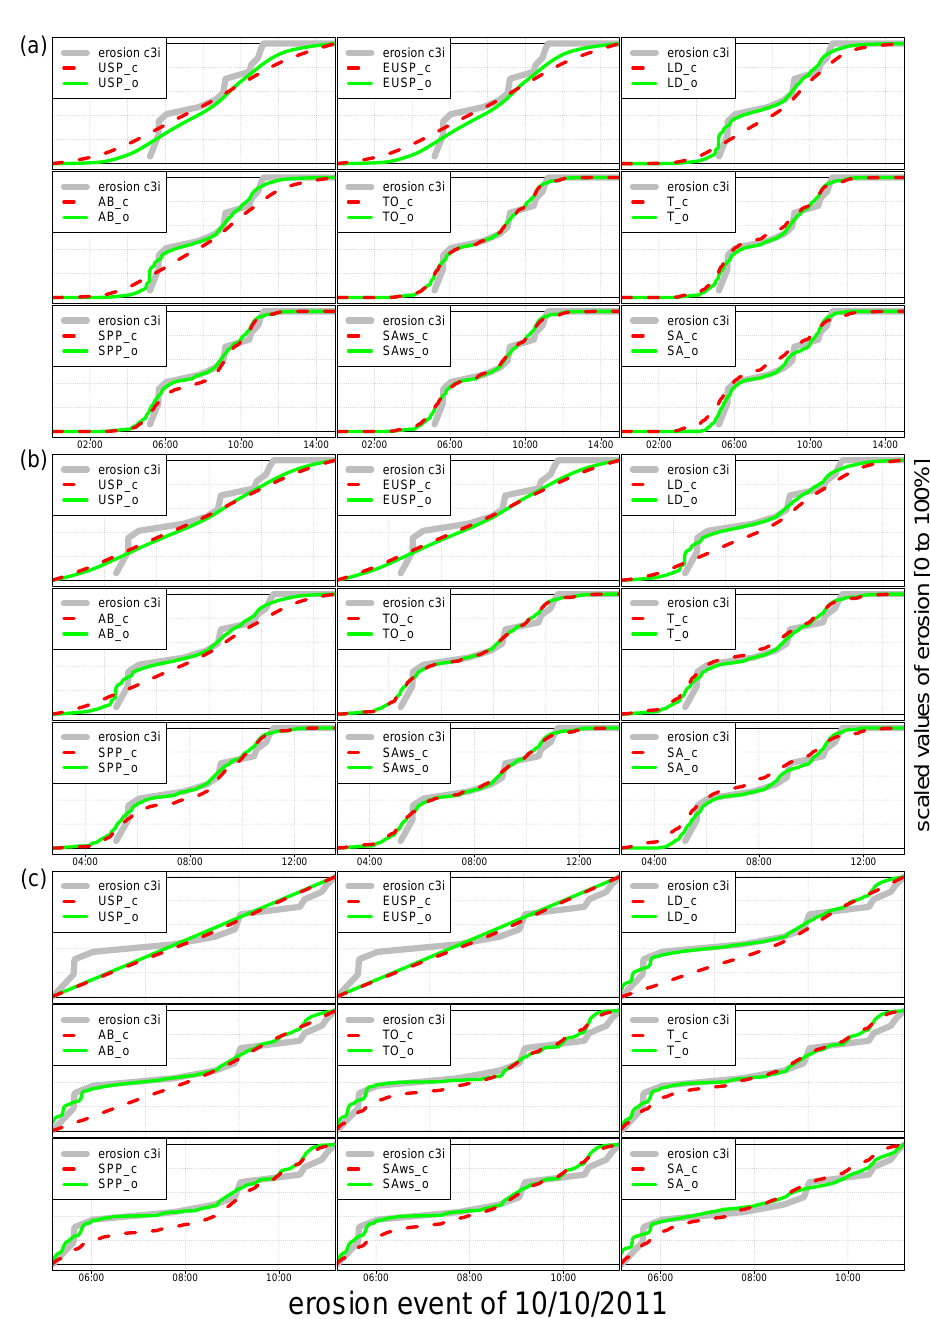
Figure B1. Separate comparison of each of the model-based erosion predictions to c3i for (a) the event period, (b) the bedload period and (c) the erosion period using the individual common and optimized parameter sets,